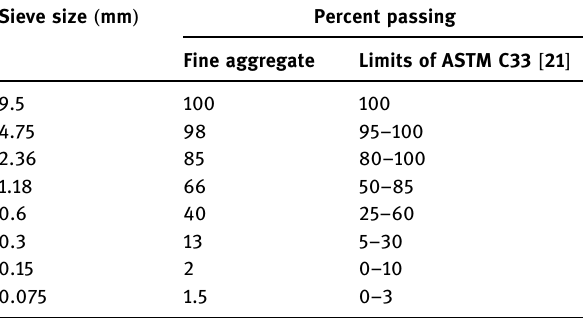
Table 2: Grading of the fi ne aggregate